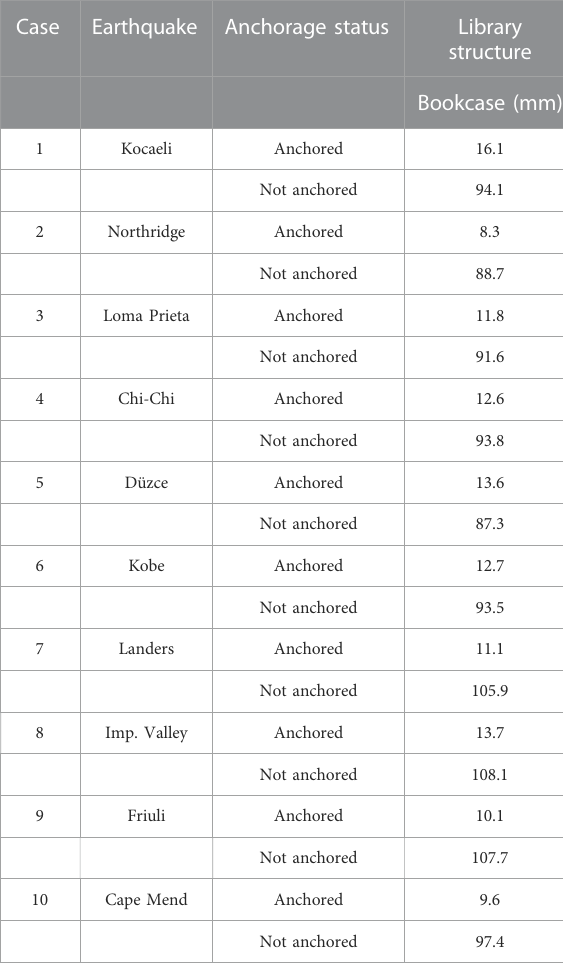
TABLE 6 Maximum seismic acceleration results for different NEs (Cavuslu, 2022).